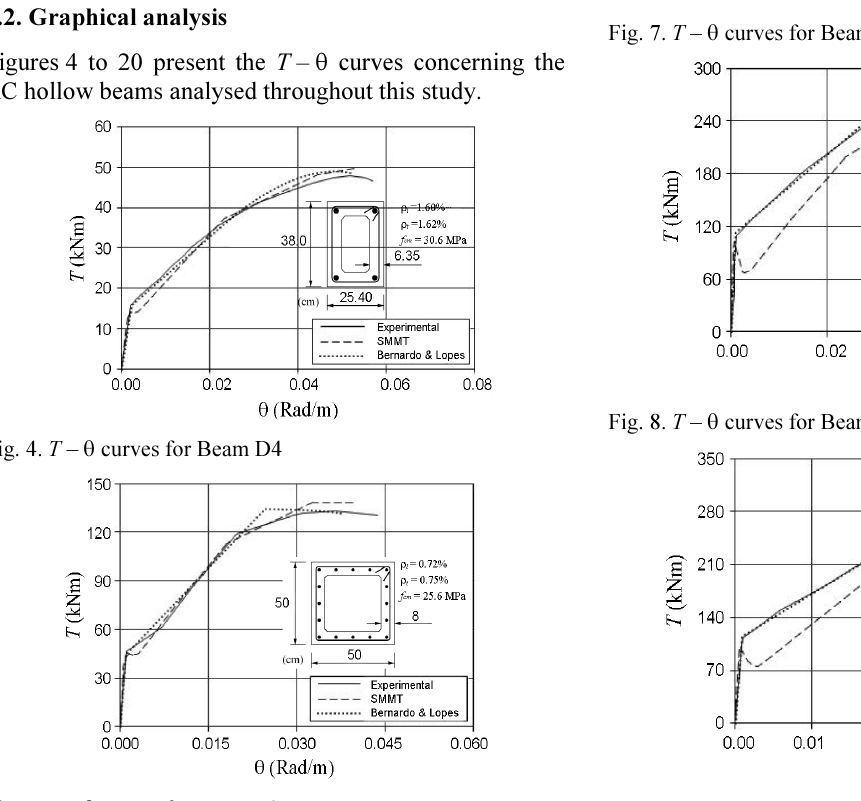
Fig. 5. T – θ curves for Beam T2